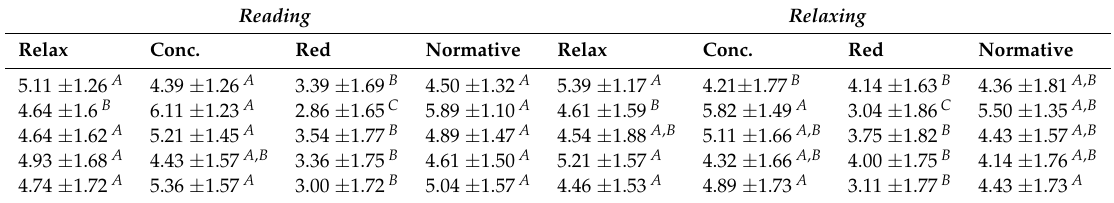
Table 3. Results of the questionnaires. Grouping information using the Turkey method and 95% confidence level (means that do not share a letter are significantly different). Conc. =